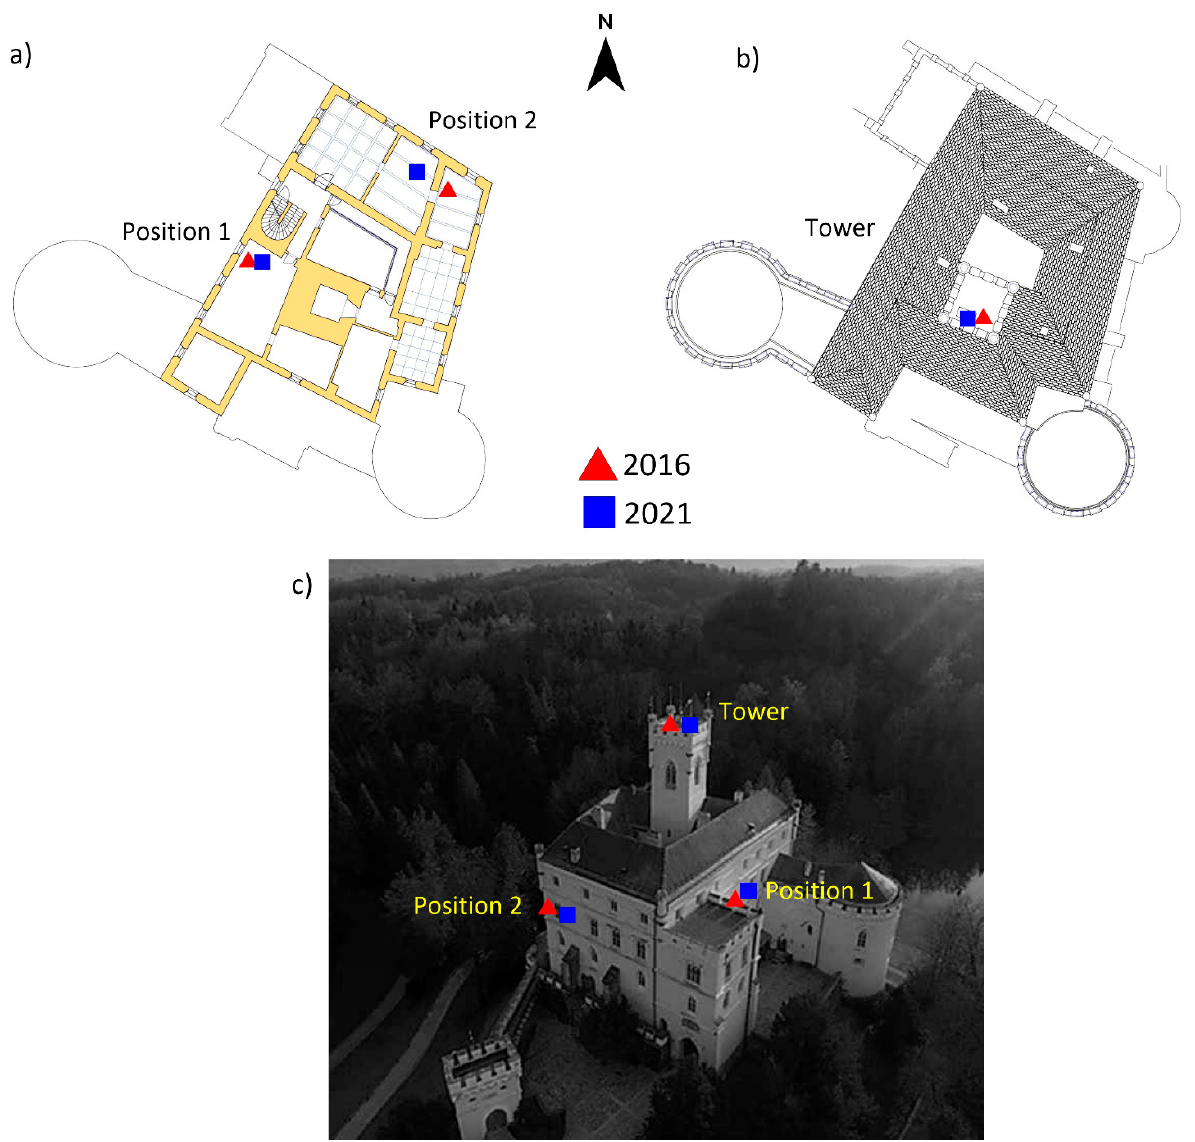
Figure 5. Positions of ambient vibration measurements; ( a ) 2nd floor plan; ( b ) Top of the Castle’s tower; ( c ) 3D model of the Castle. Red triangles and blue squares mark measurement positions in 2016 and 2021, respectively. Please note that the North arrow is valid for ( a , b ) plans. Table 1. Estimated fundamental frequencies and periods based on the 2016 and 2021 ambient noise measurements.